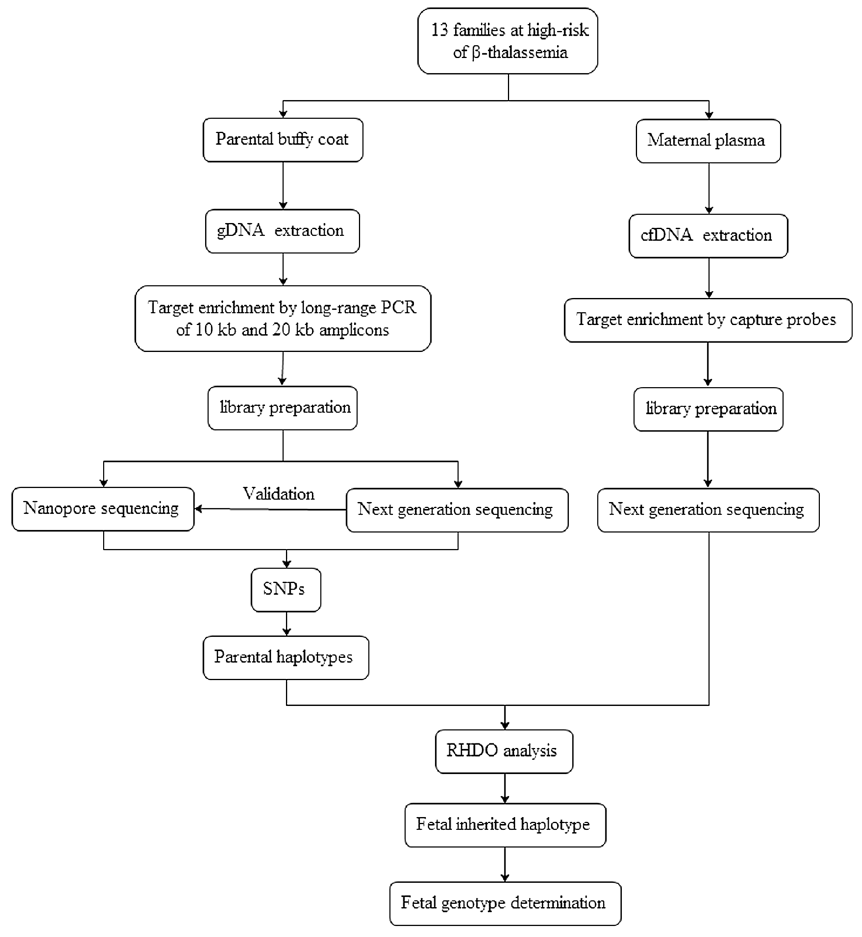
Figure 3. The work flow of this